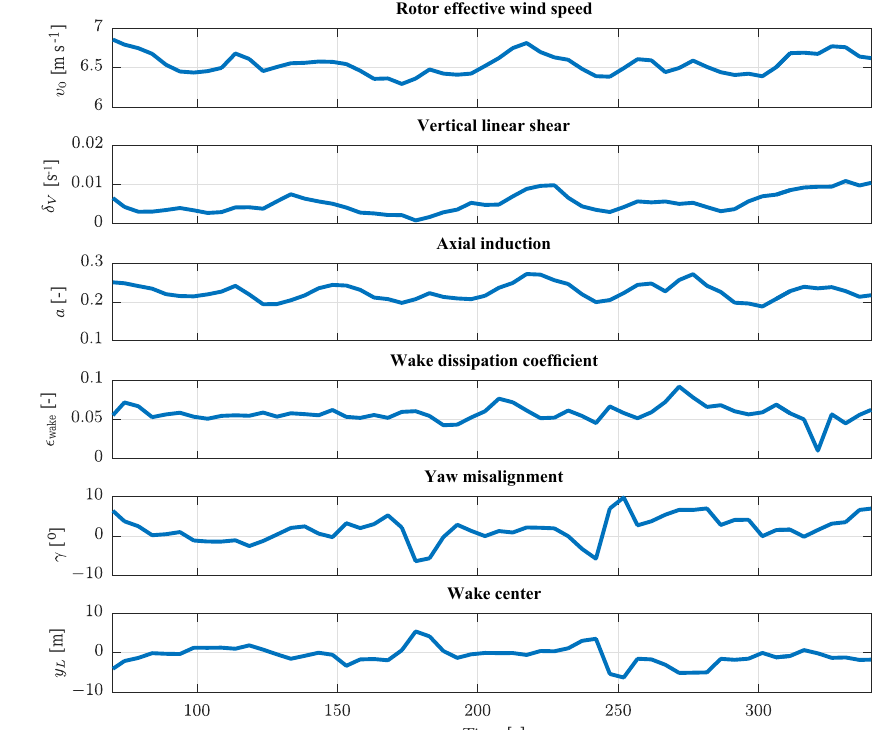
Figure 8. Time results of the wake tracking of a SOWFA simulation. The wind turbine is aligned with the mean wind direction. The lidar scanned in a 7 × 7 grid at five distances from 0.6 to 1.4 D . The wake center is estimated at the furthest scanning distance 1.4 D =